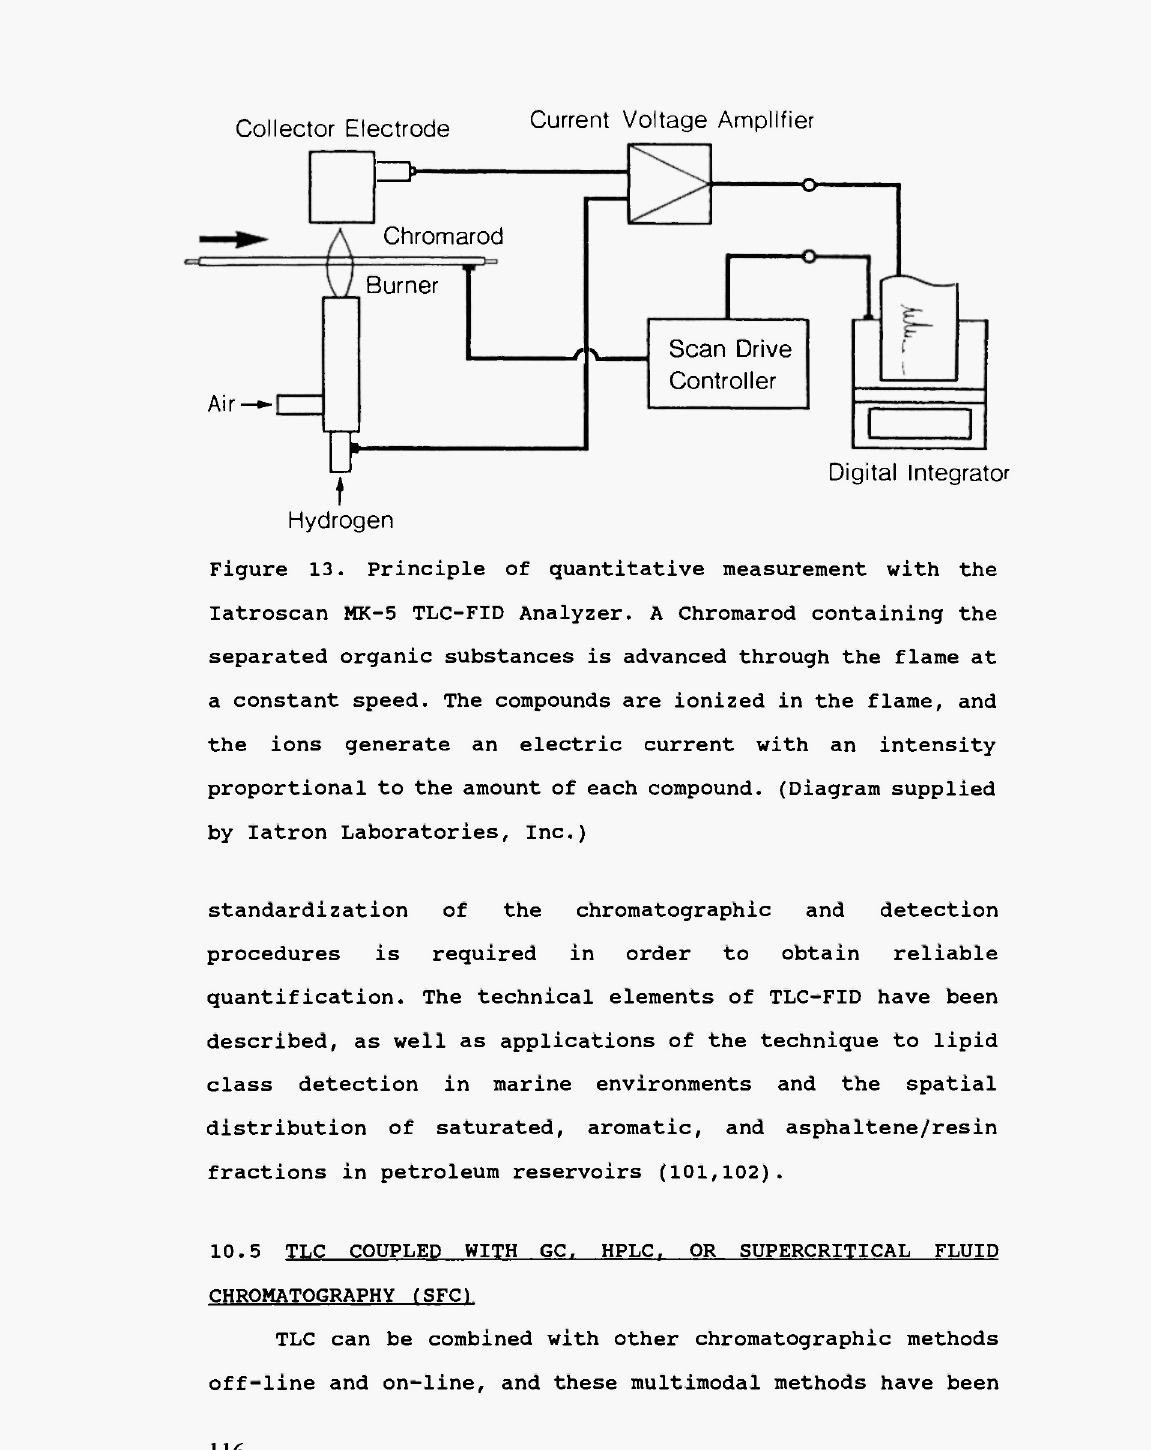
Figure 13. Principle of quantitative measurement with the Iatroscan MK-5 TLC-FID Analyzer. A Chromarod containing the separated organic substances is advanced through the flame at a constant speed. The compounds are ionized in the flame, and the ions generate an electric current with an intensity proportional to the amount of each compound. (Diagram supplied by Iatron Laboratories,